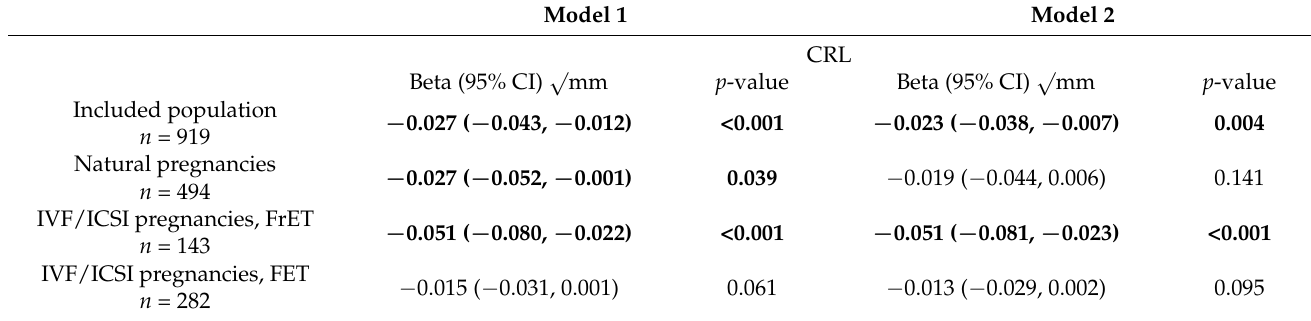
Table 2. Association between maternal homocysteine and longitudinal first trimester embryonic CRL and EV in the included population ( n = 1060), natural pregnancies ( n = 555) and IVF/ICSI pregnancies ( n =